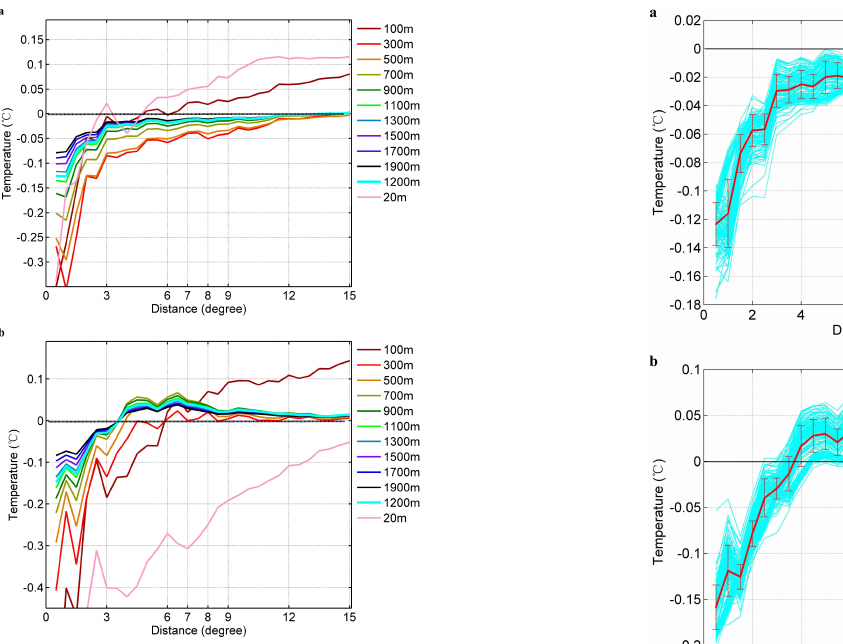
Figure 12. Column-averaged temperature anomalies within 4– 20 days after tropical cyclones, relative to pre-storm conditions, as a function of the horizontal box size across the storm track (from ± 1 ◦ to ± 15 ◦ ) for (a) TS/TD and (b) hurricanes. The colors are dif- ferent vertical sizes of the TC-affected box from 100 to 1900m. The results for the box with 1200m depth are highlighted in cyan.